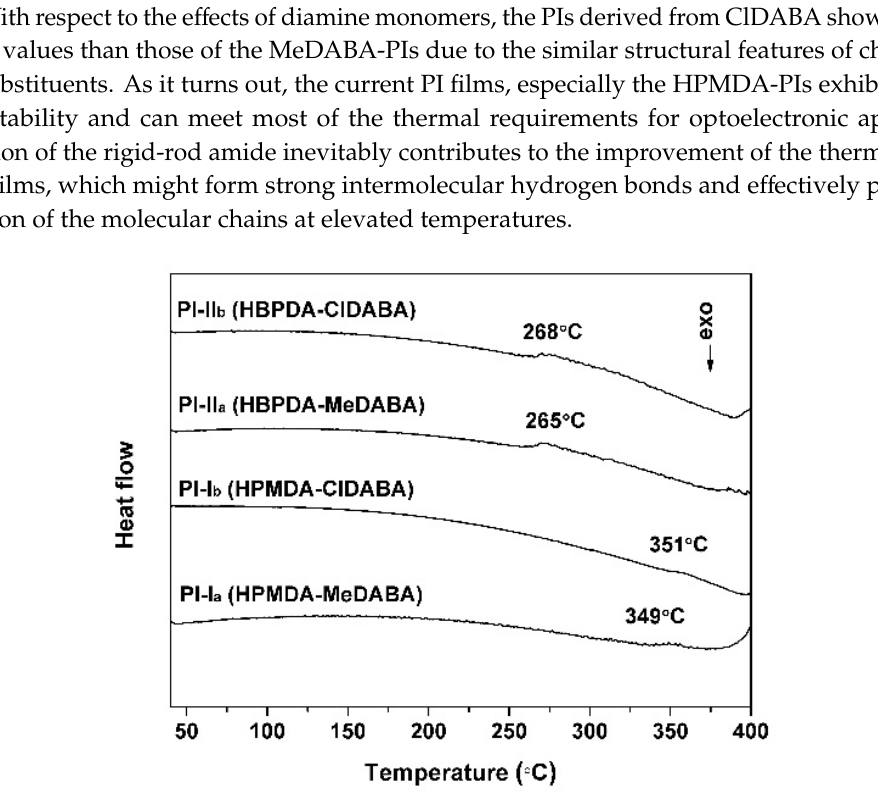
Figure 11. DSC curves of PI films.